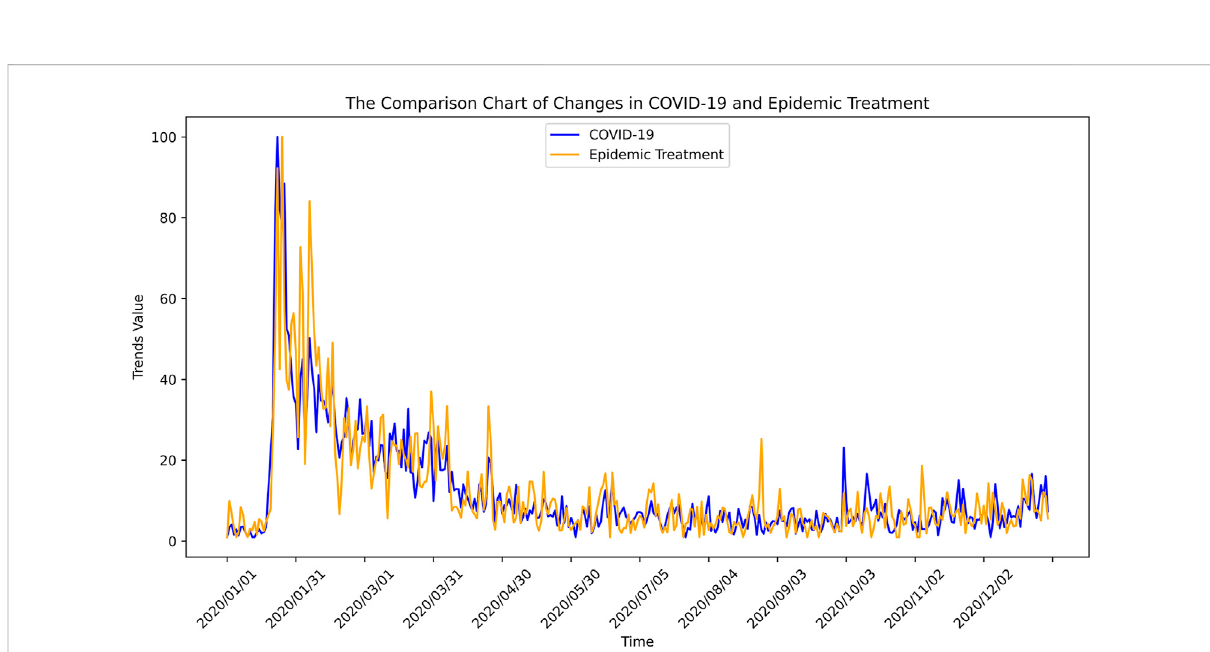
FIGURE 5 The comparison chart of changes in the attention of COVID-19 and epidemic